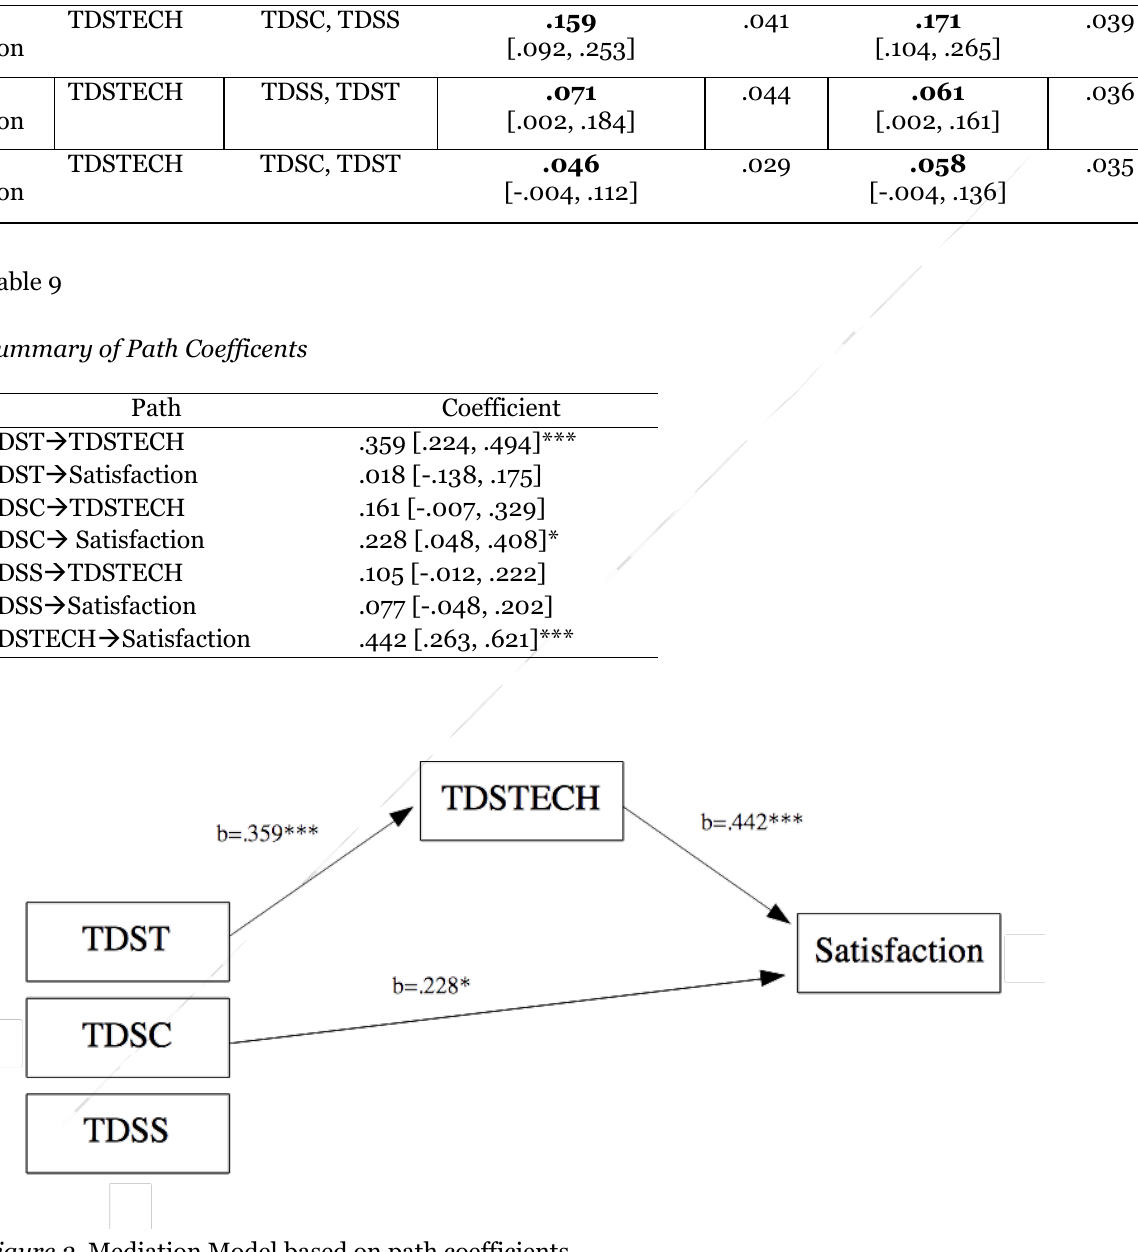
Figure 2. Mediation Model based on path